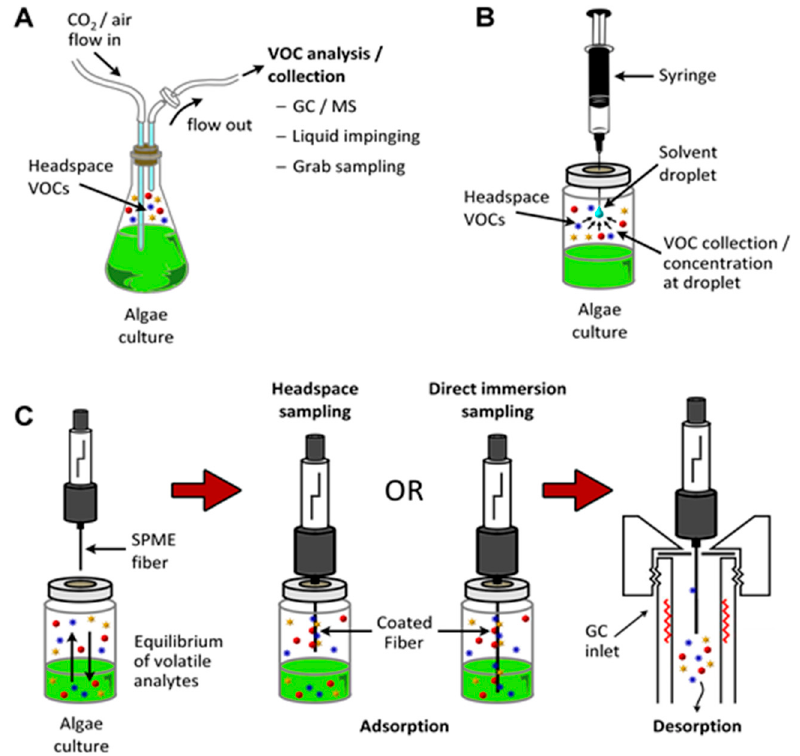
Figure 16. VOC sampling techniques: ( A ) Sampling of headspace by gas flow or collection by liquid impingement or grab sampling; ( B ) SME; ( C ) SPME by adsorption of VOCs from headspace or from